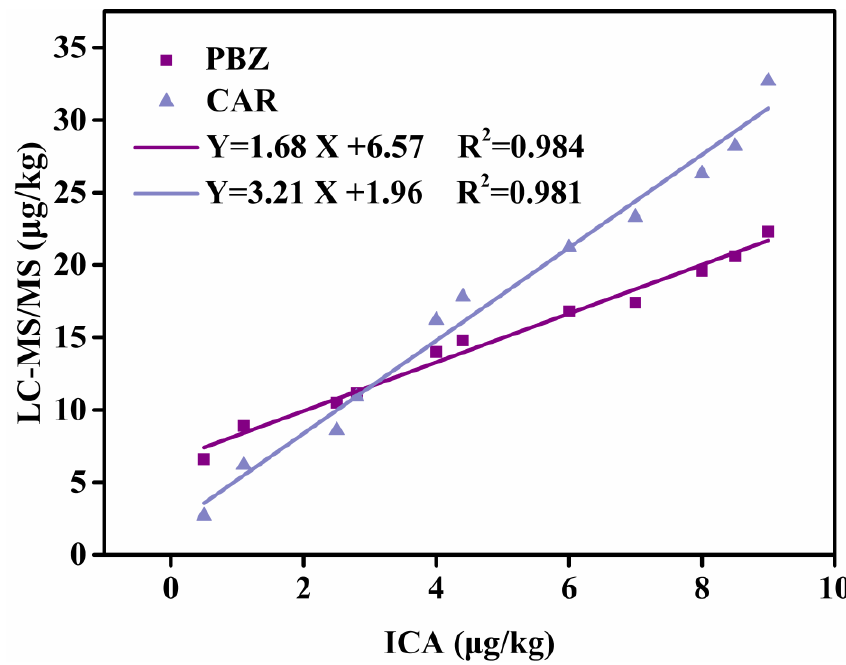
Figure 5. Correlation curve of dual-color ICA with LC–MS/MS.